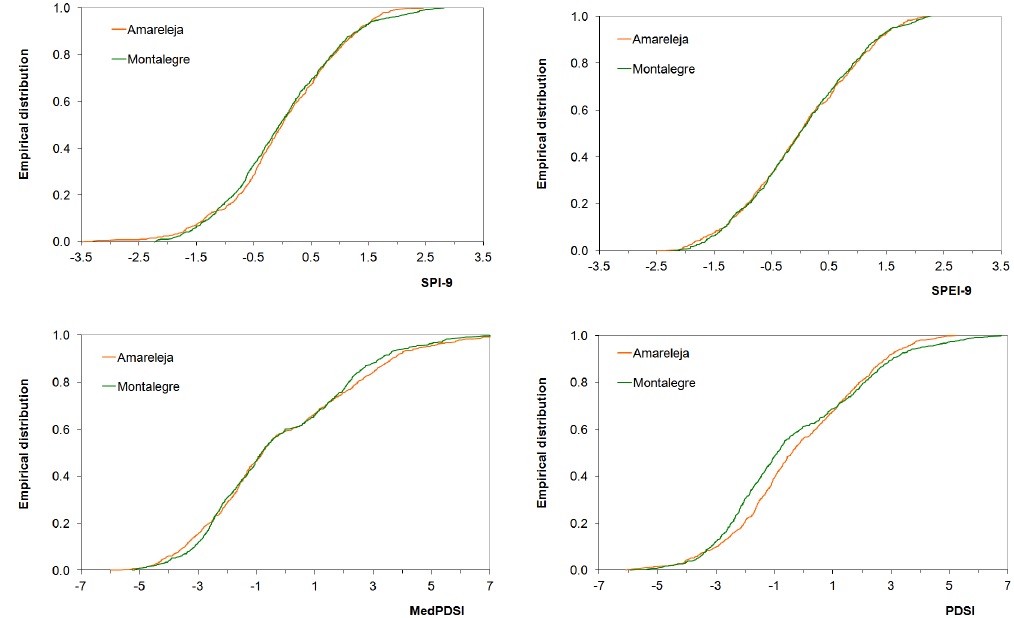
Fig. 3. Empirical distributions of SPI-9, SPEI-9, MedPDSI and PDSI in Amareleja (semi-arid) and Montalegre (humid) computed for the period